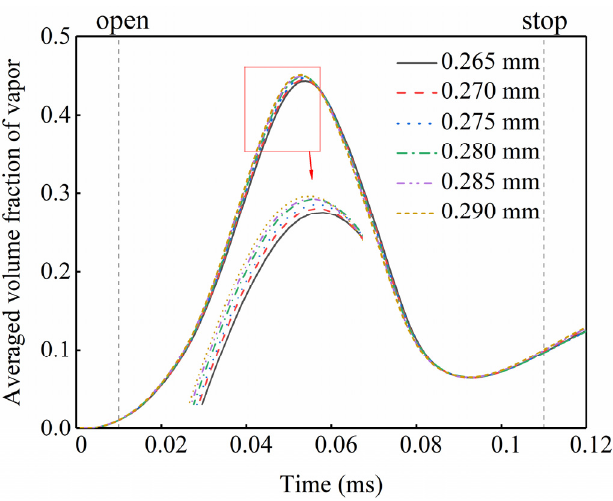
Figure 9. Flow characteristic curve of control valve with outlet throttle diameter deviation.